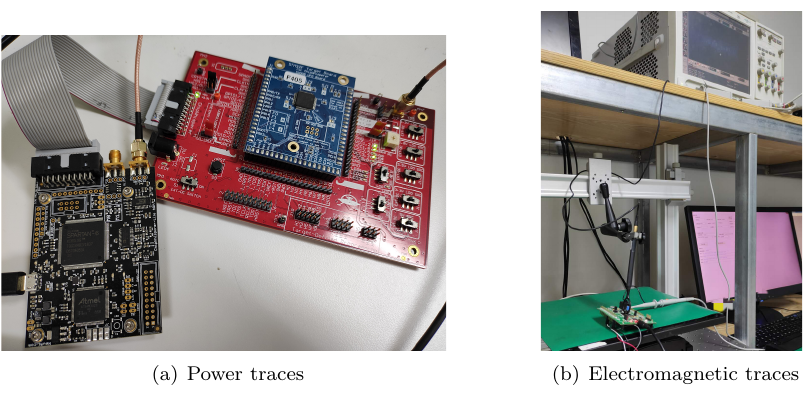
Figure 7: Our experimental environment for collecting power and electro-magnetic leakages. from F rp , F a , F b and F c respectively. To measure the side-channel resistance against A 2 , the metric P [ PD ( F )] is used as shown in Table. 2. Table 2: The measurement of side-channel resistance of four addition chains using PD . Addition Chain F a F rp F b max[ PD ( F